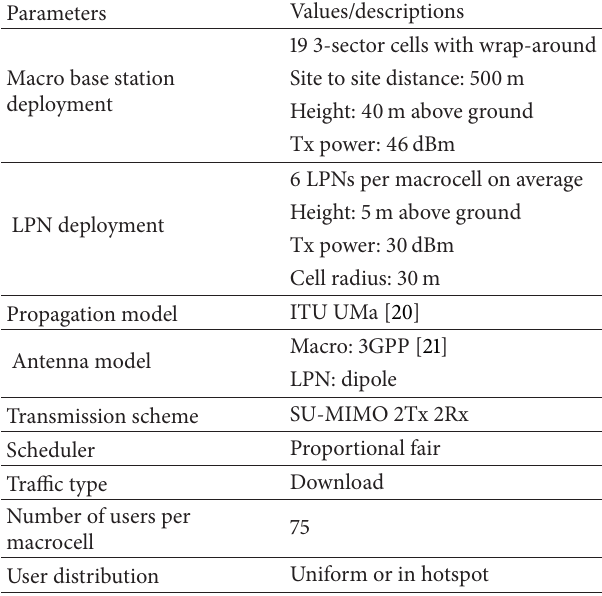
Table 1: System evaluation assumptions and parameters.